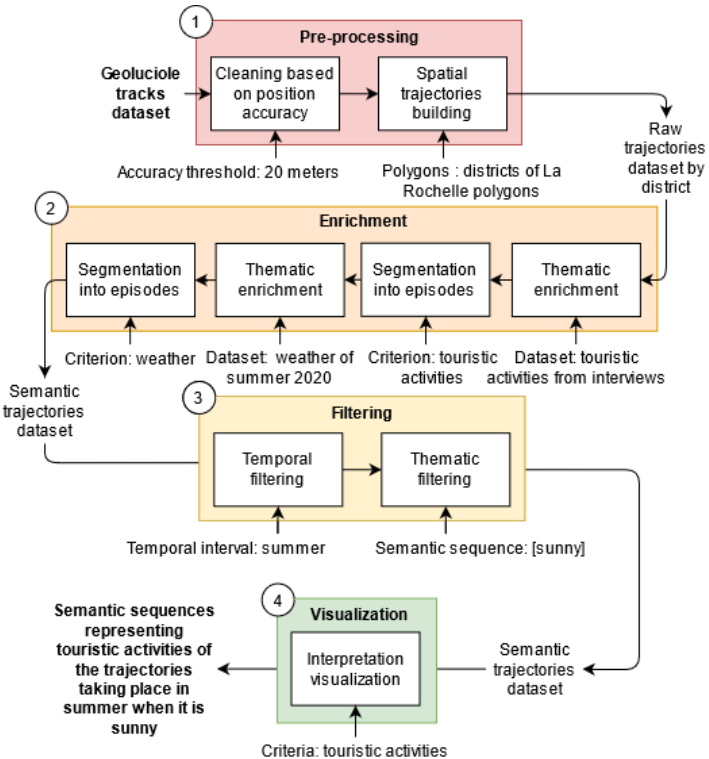
Figure 6. Customized processing chain to answer question